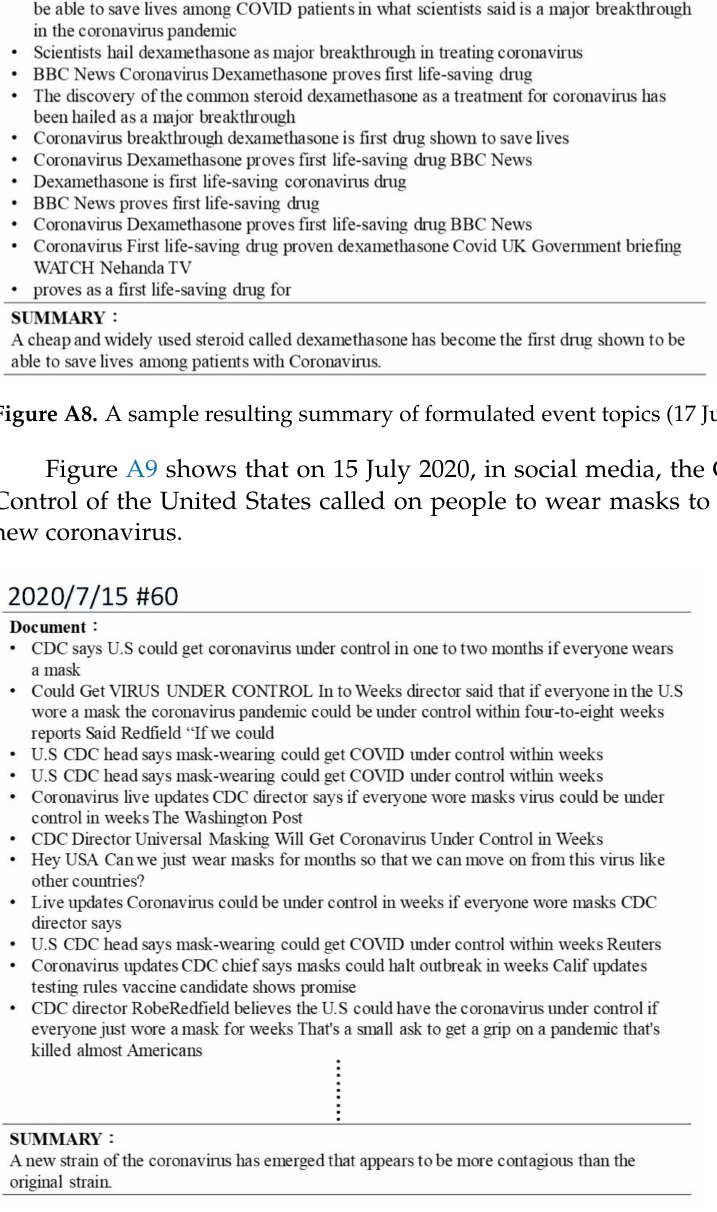
Figure A9. A sample resulting summary of formulated event topics (15 July